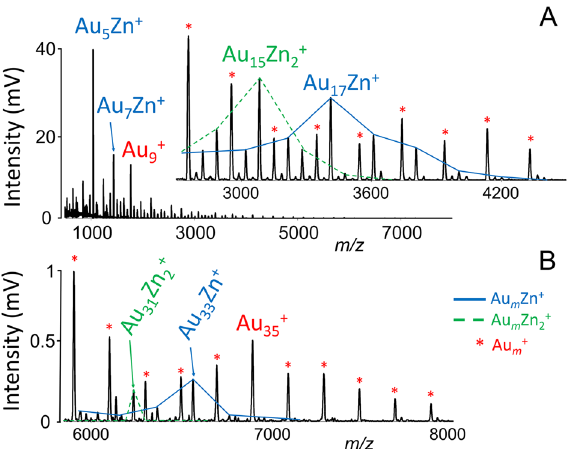
Figure 3. LDI mass spectra of {AuNPs, Zn-MOF} composite showing distribution of Au m Zn n + over the m / z region; gold clusters are marked as ‘*’. Conditions: positive linear ion mode, laser energy 170 a.u. Solid lines have no physical meaning and were used for the sake of